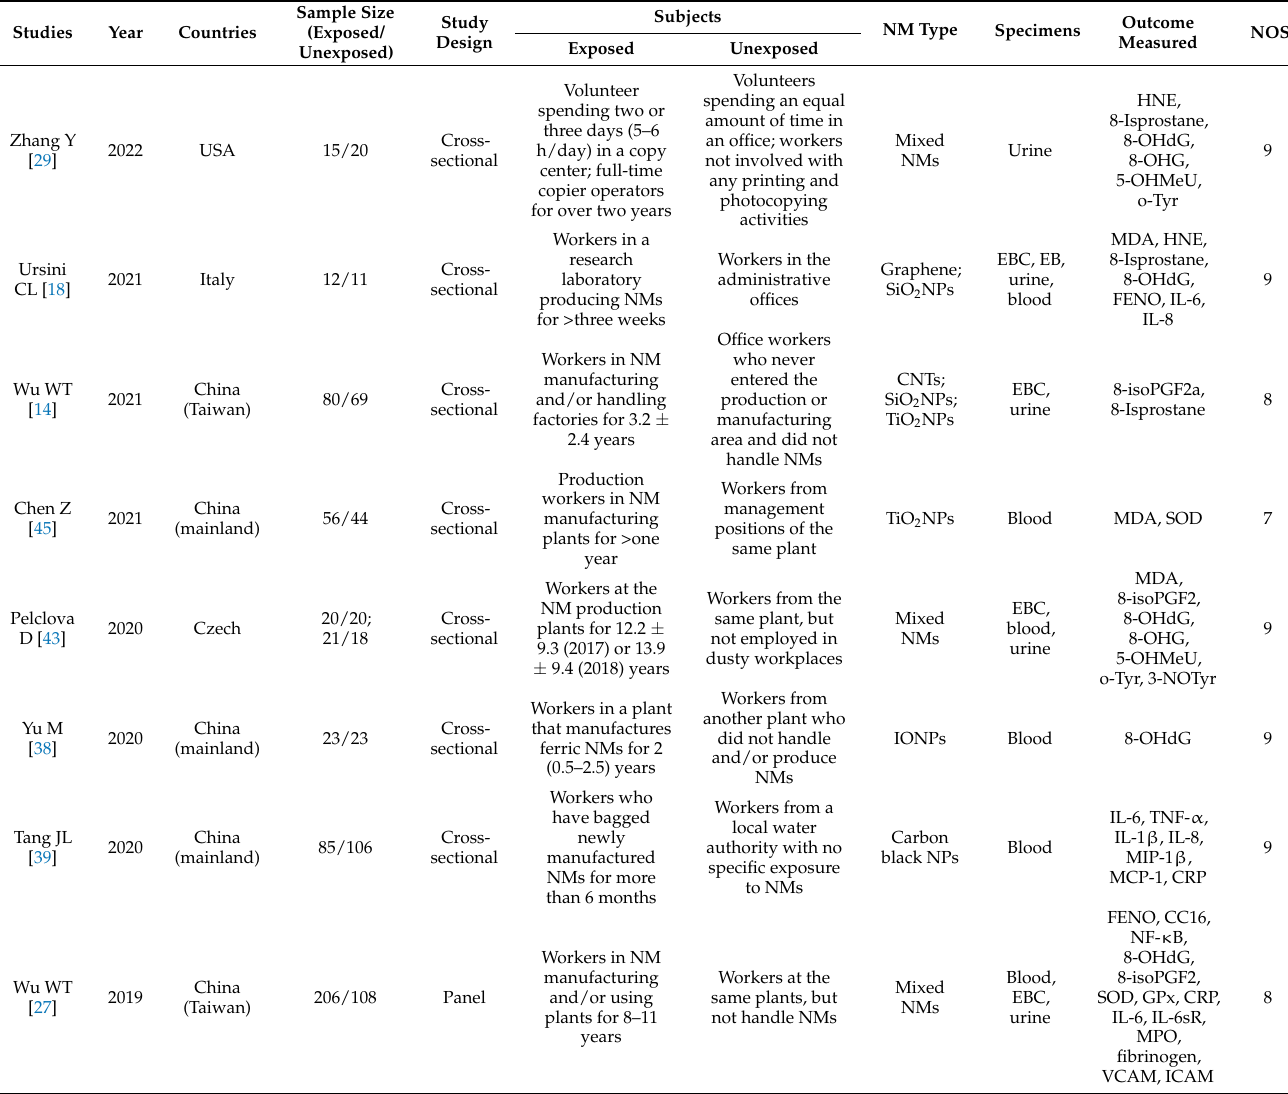
Table 1. Characteristics of included